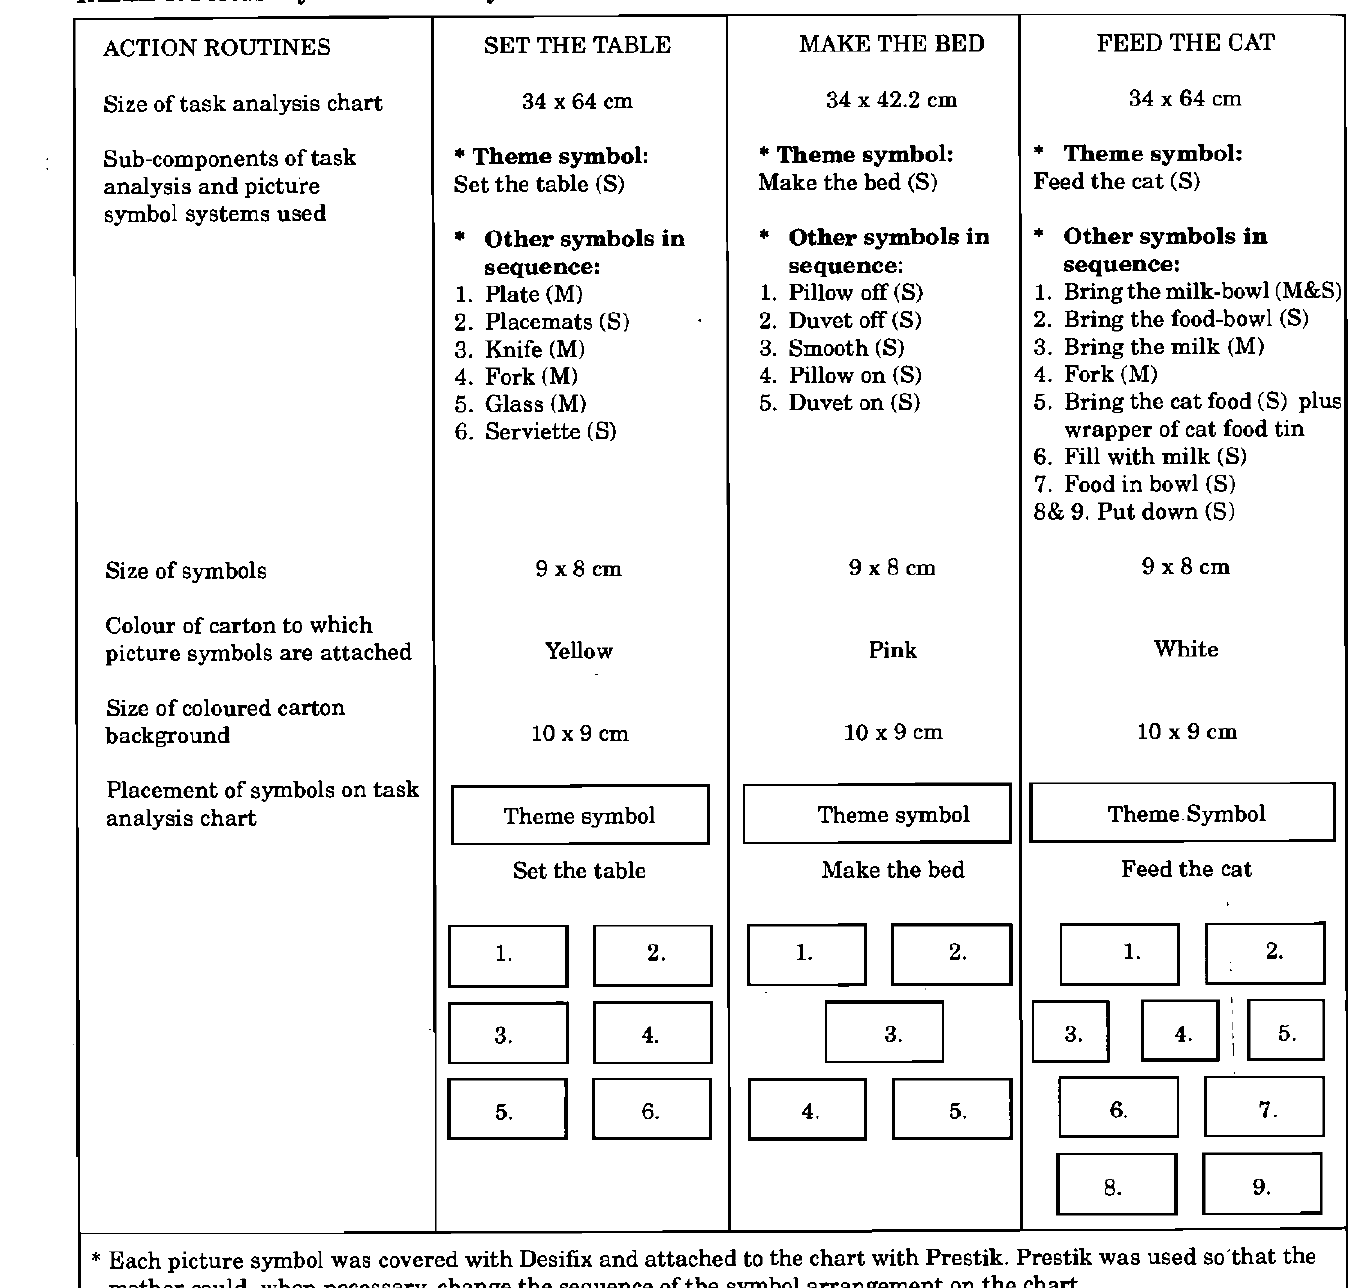
TABLE 3: Picture symbol task analysis of action routines ACTION ROUTINES Size of task analysis